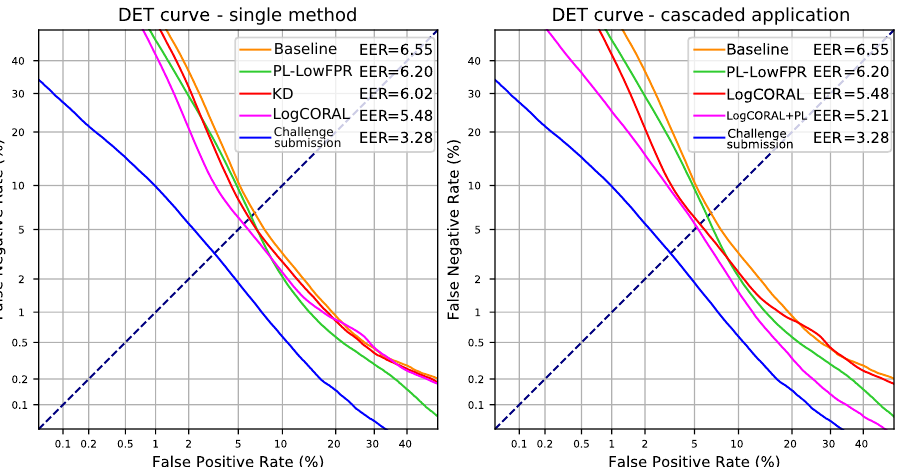
Figure 8. DET curve and EER (%) on the FS02 development partition using the three evaluated domain adaptation methods ( left ), and the cascaded application of two of them ( right ) with the best performing hyperparameter configuration in terms of DCF metric compared to the unadapted baseline system and our submission to the challenge trained using in domain